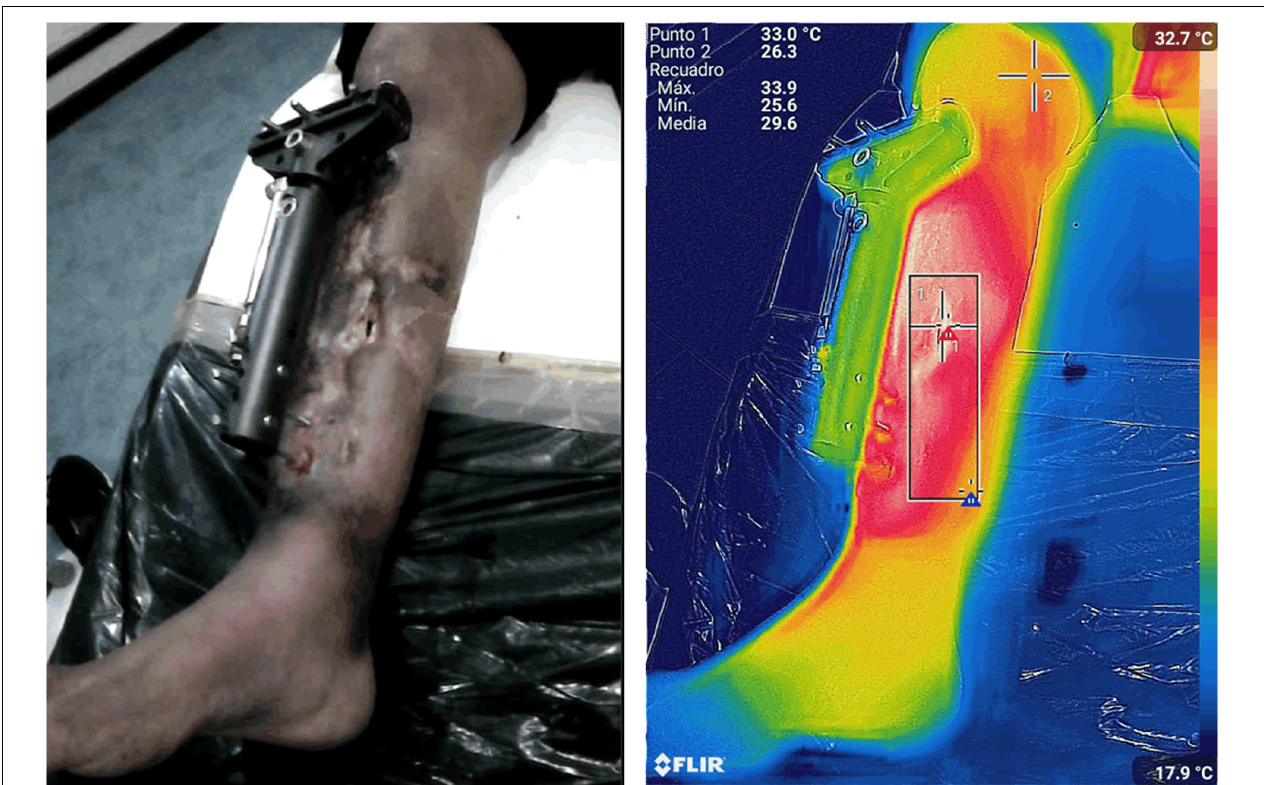
FIGURE 8 | Assessment of a surgical site infection. Infrared thermography was used to monitor the extent of a surgical site infection following the external reduction of an open tibial fracture. The thermogram shows an area of extensive inflammation with the maximum thermal signal in the region of interest (ROI) bounded by the box. Images, courtesy of JR-G, were acquired using the Skin and Wound mobile app (Swift Medical Inc., Toronto, ON, Canada) paired to FLIR One Pro